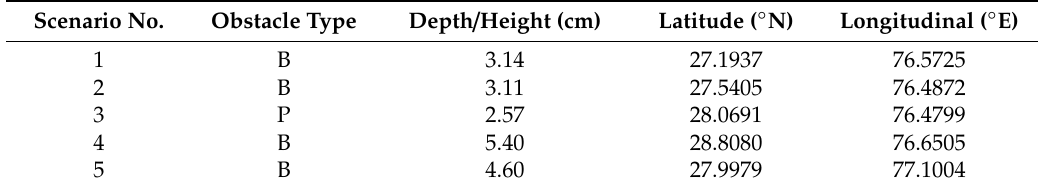
Table 5. Information of pothole (P) and bumps (B) collected during real-time testing using the image processing method for the R1 test site.